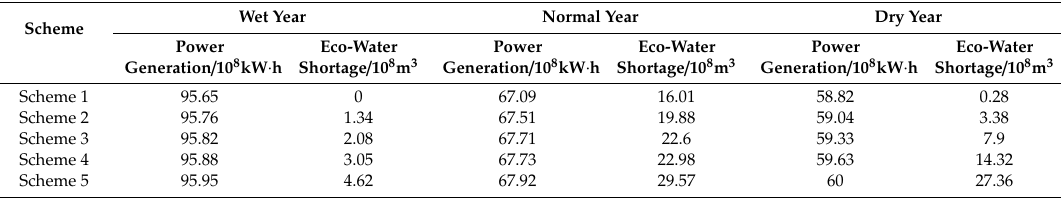
Table 5. Comparative analysis of various schemes in typical